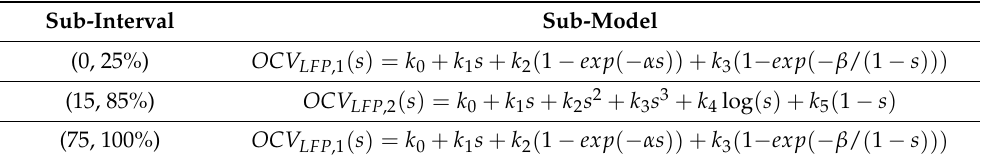
Table 2. Sub-models of LFP